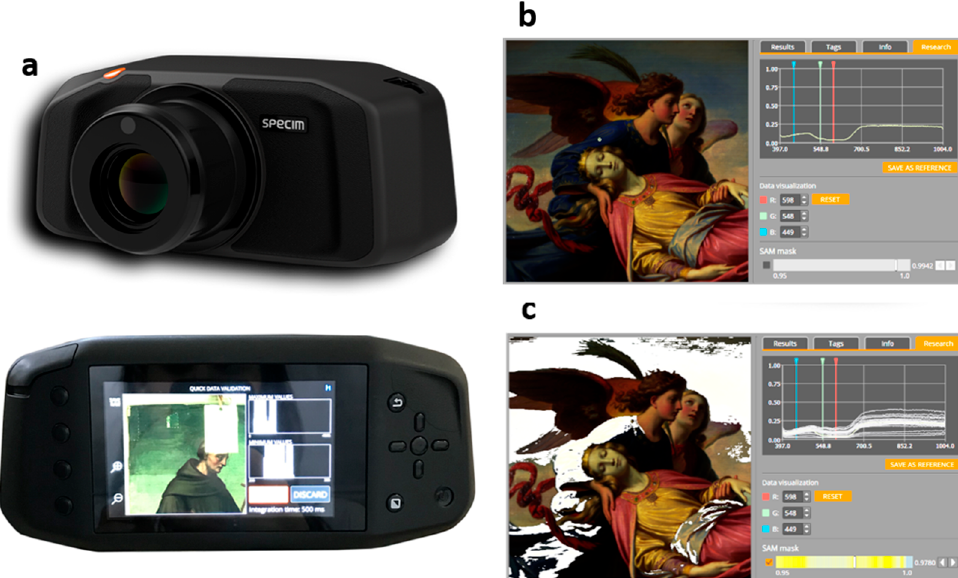
Figure 3. ( a ) Specim IQ hyper-spectral camera; ( b ) image displayed in the camera’s screen with the pixel’s reflectance spectrum; ( c ) cobalt blue distribution map provided by the SAM algorithm in the camera software (in white) on the painting’s surface (figure modified from [60]).